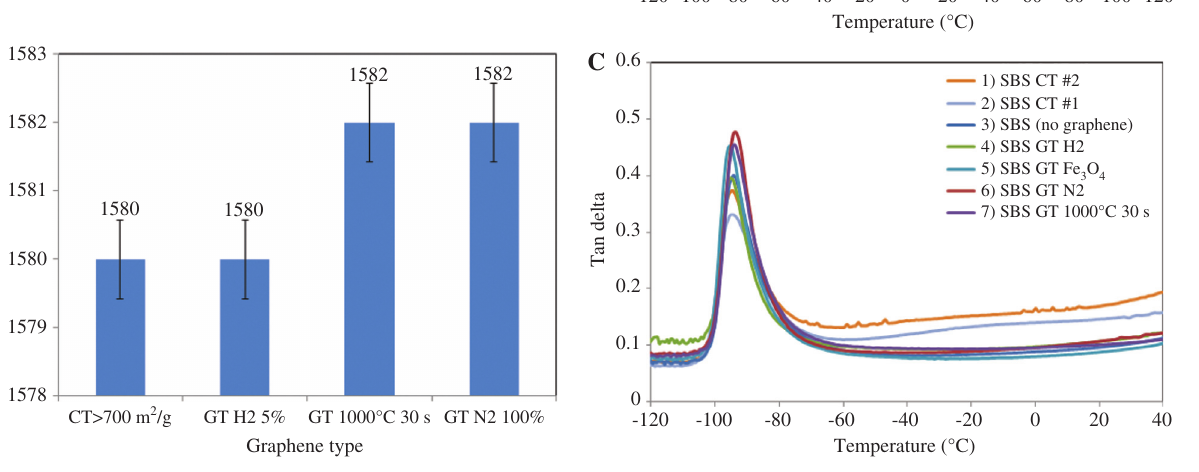
FIgure 6 DMA of graphene-SBS composites: (A) storage modulus, (B) loss modulus, and (C) tan( δ ).